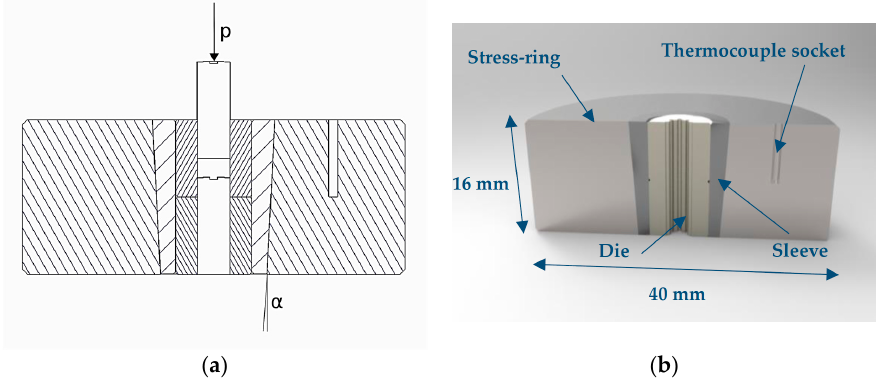
Figure 2. Tool system design for the shrink-fit application: ( a ) stress-ring, sleeve and die section; and ( b ) rendered CAD model of the stress-ring, sleeve and die.